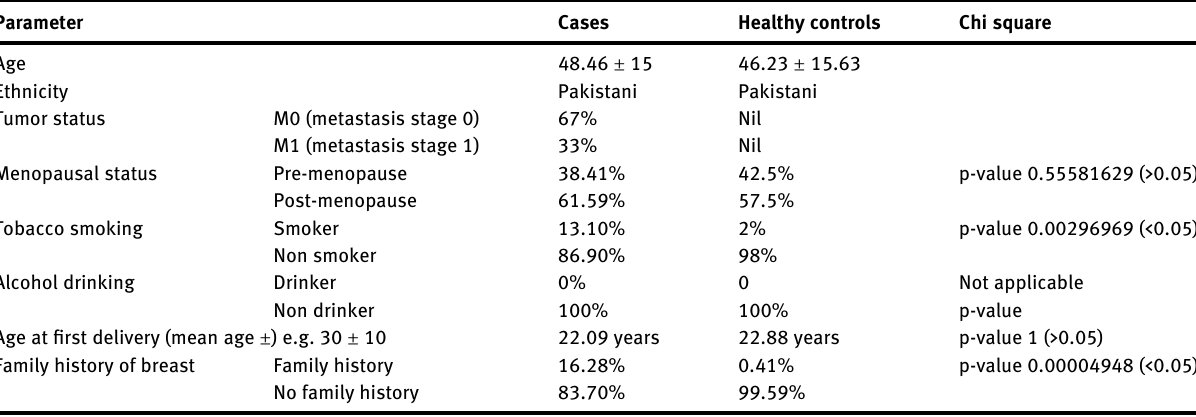
Table  : Demographic characteristics of case and healthy